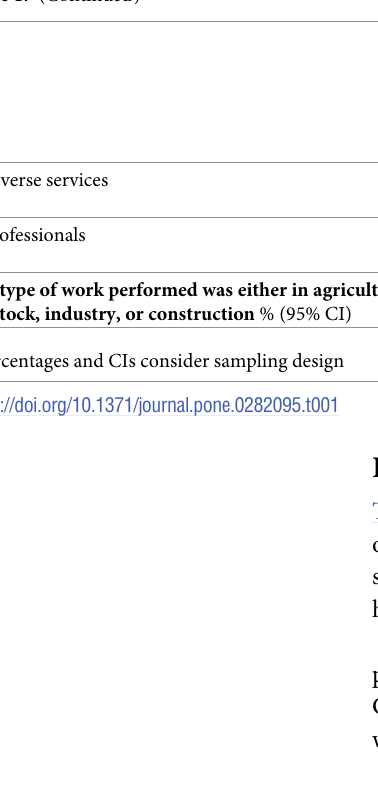
Job status Total Worked during their last trip to